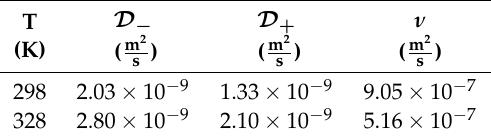
Table 4. Transport properties of the fluid at temperatures considered, reported diffusivities by Bastug and Kuyucak [48], and viscosities by Tseng et al.